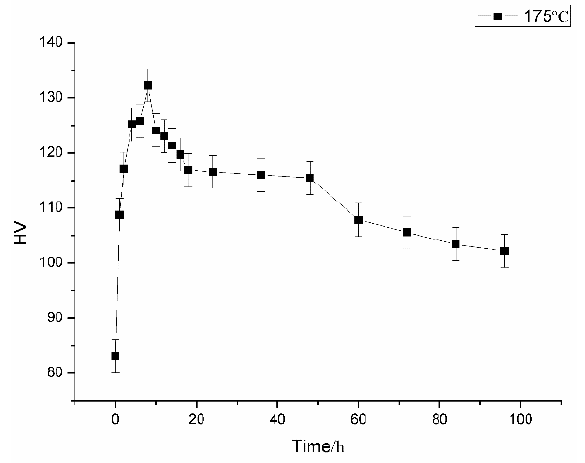
Figure 1. Hardness curve of artificial aging (AA) specimens.